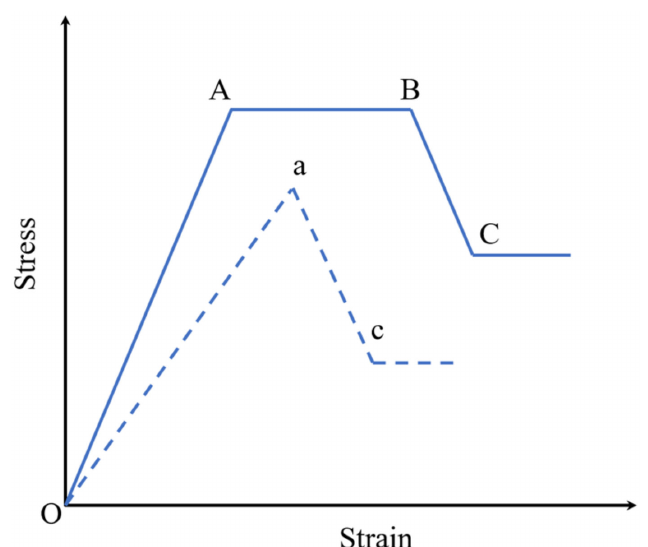
Figure 5. Schematic diagram of brittle to plastic transition caused by yield platform. Note: a is the peak point, A and B are the starting and ending points of the yield plateau, c and C are the residual points of different models